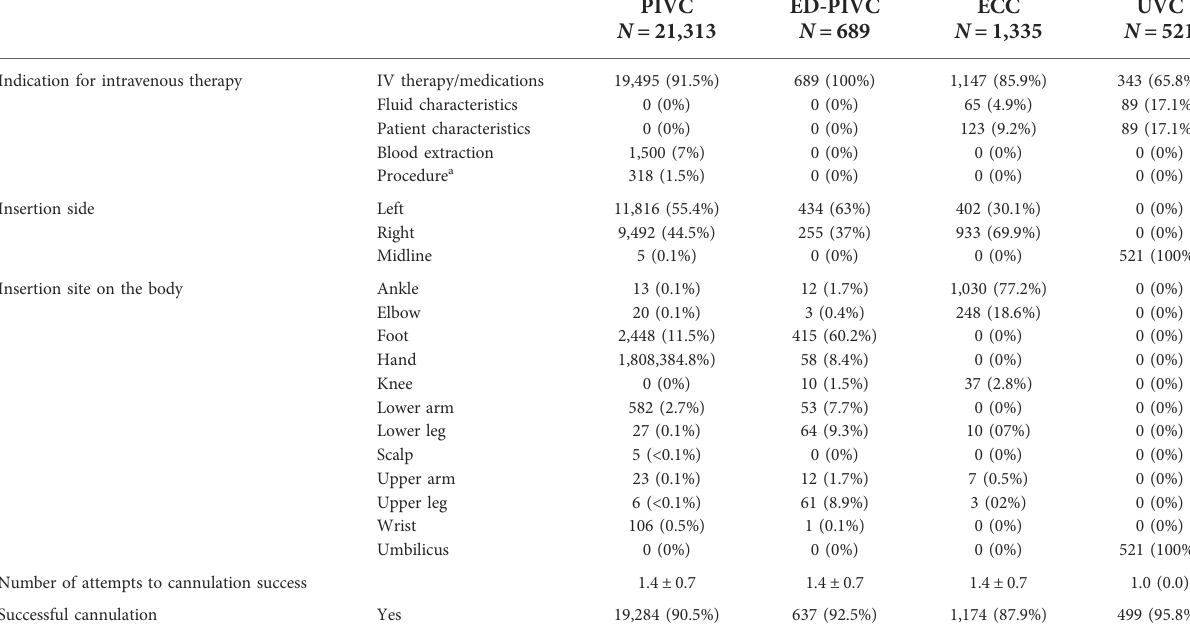
TABLE 2 Data related to the insertion of the